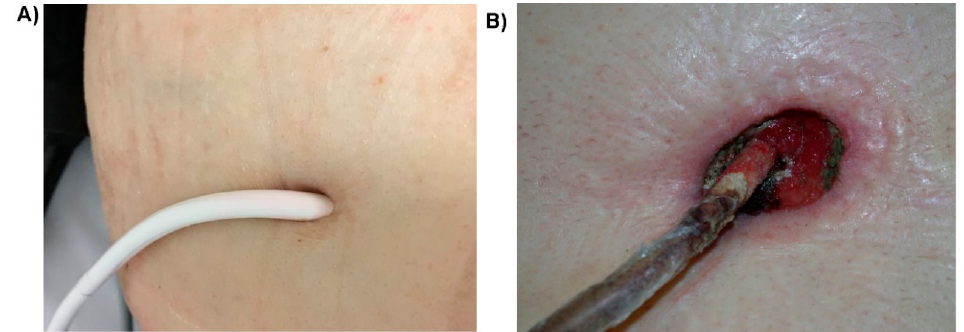
Figure 2. Driveline exit-site infection. ( A ) Uninfected control. The patient received a HeartMate II VAD system (Abbott, Plymouth, MN, USA). ( B ) A typical driveline exit-site infection that demonstrates tissue destruction and granulation tis- sue. A HeartWare HVAD system (Medtronic, Minneapolis, MN, USA) was used in the patient.